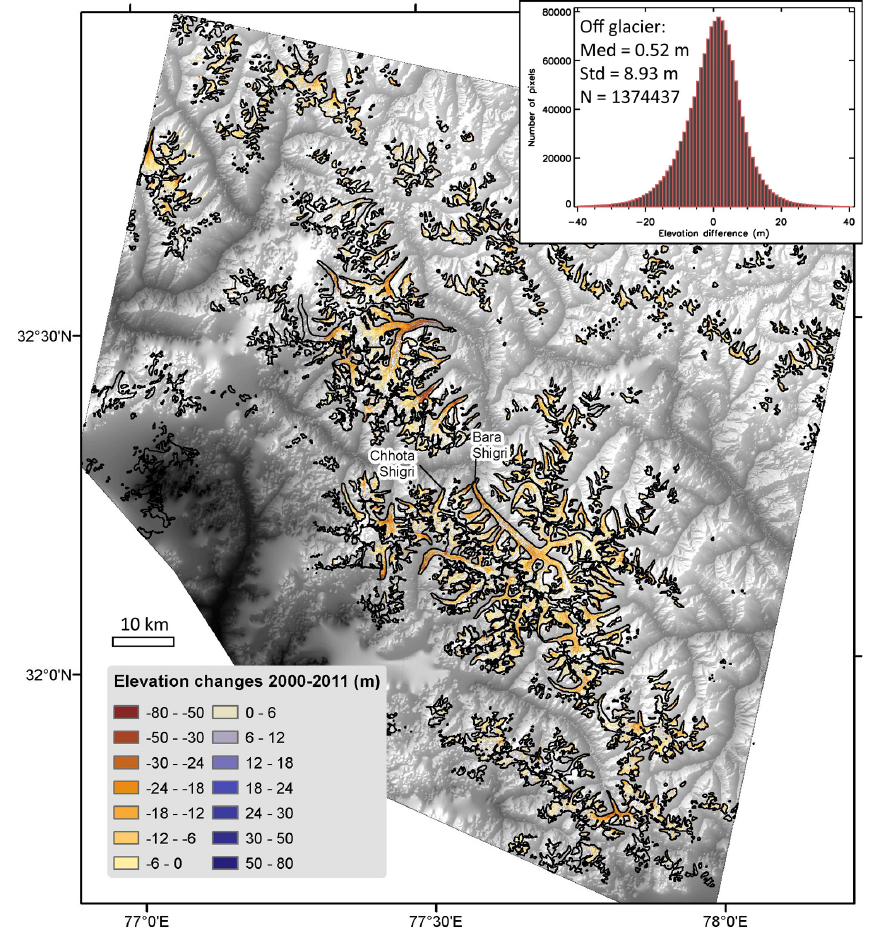
Fig. 6. Same as Fig. 2 but for the Spiti Lahaul study site. The map of elevation changes contains many voids, due to the presence of thin clouds during the acquisition of the SPOT5 DEM. The mass balance of the Chhota Shigri and Bara Shigri glaciers are, respectively, − 0.39 ± 0.18mw.e.yr − 1 and − 0.48 ± 0.18mw.e.yr − 1